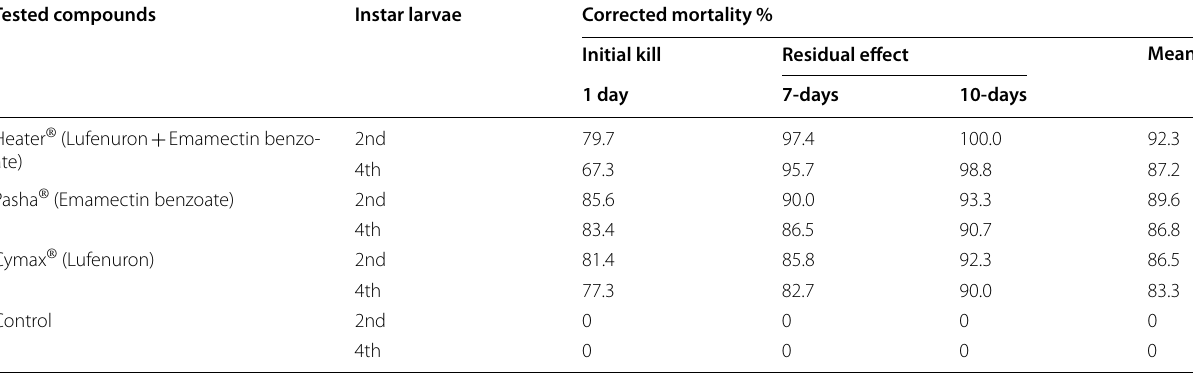
Table 2 The corrected larval mortality percentage of the 2nd and 4th instar larvae of the cotton leafworm S. littoralis after treatment with the tested compounds during 2019 growing season in Beheira governorate Tested compounds